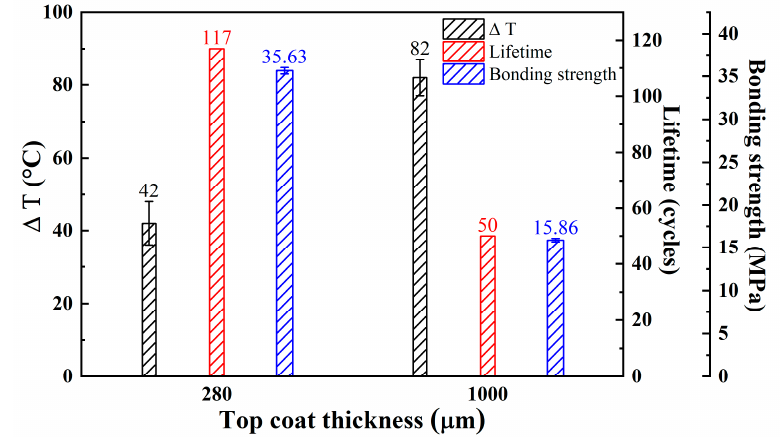
Figure 8. Effect of topcoat thickness on coating thermal insulation ( Δ T is the difference between the surface temperature of the uncoated substrate and the surface temperature of the substrate coated with the TBC), thermal shock lives (at 1000 ℃ ), and bonding strength. (adapted from [52] ).